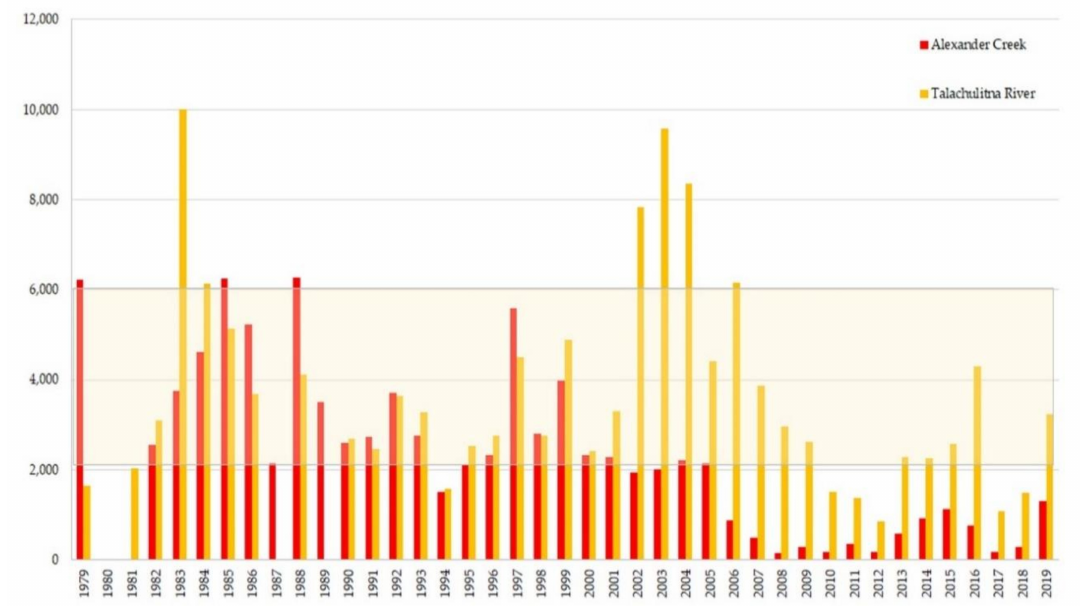
Figure 2. Alexander Creek (pike present) and Talachulitna River (pike not present) aerial survey counts for Chinook salmon escapement. The shaded area shows the escapement goal range (sustainable abundance range) for Alexander Creek Chinook salmon. The escapement goal range for the Talachuitna River is 2200 to 5000 Chinook salmon.